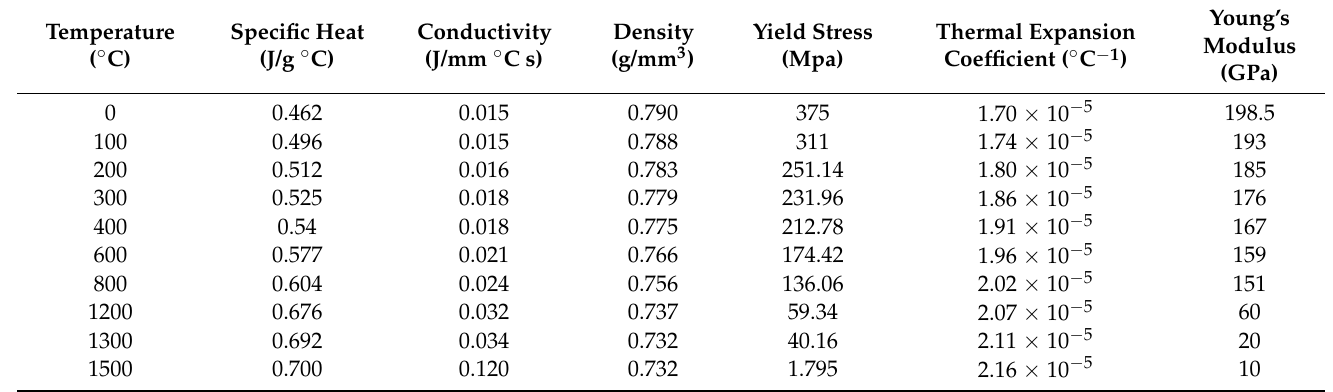
Table 2. Thermal and mechanical properties of steel.